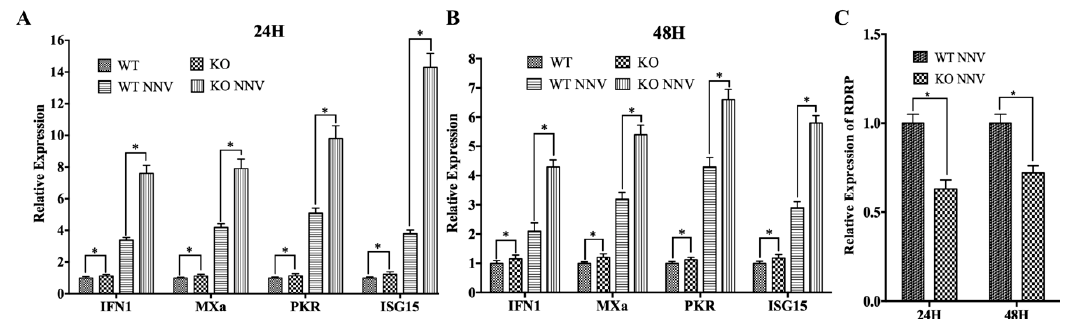
Figure 3. miR-202-5p knockout inhibits antiviral genes expression and promotes RGNNV infection in vivo. Adult wild type (WT) and miR-202-5p -/- zebrafish (KO) were intraperitoneally injected with RGNNV or the same volume of PBS. Twenty-four and forty-eight hours later, zebrafish were harvested and expression levels of IFN 1 , MXa , PKR , and ISG15 ( A and B ) and RDRP ( C ) were analyzed by qRT-PCR. The relative expression levels were normalized with 18s rRNA and represented as fold induction relative to the transcription level in the control (WT), which was regarded as 1. Asterisks indicate the significant differences between groups (*: p < 0.05).